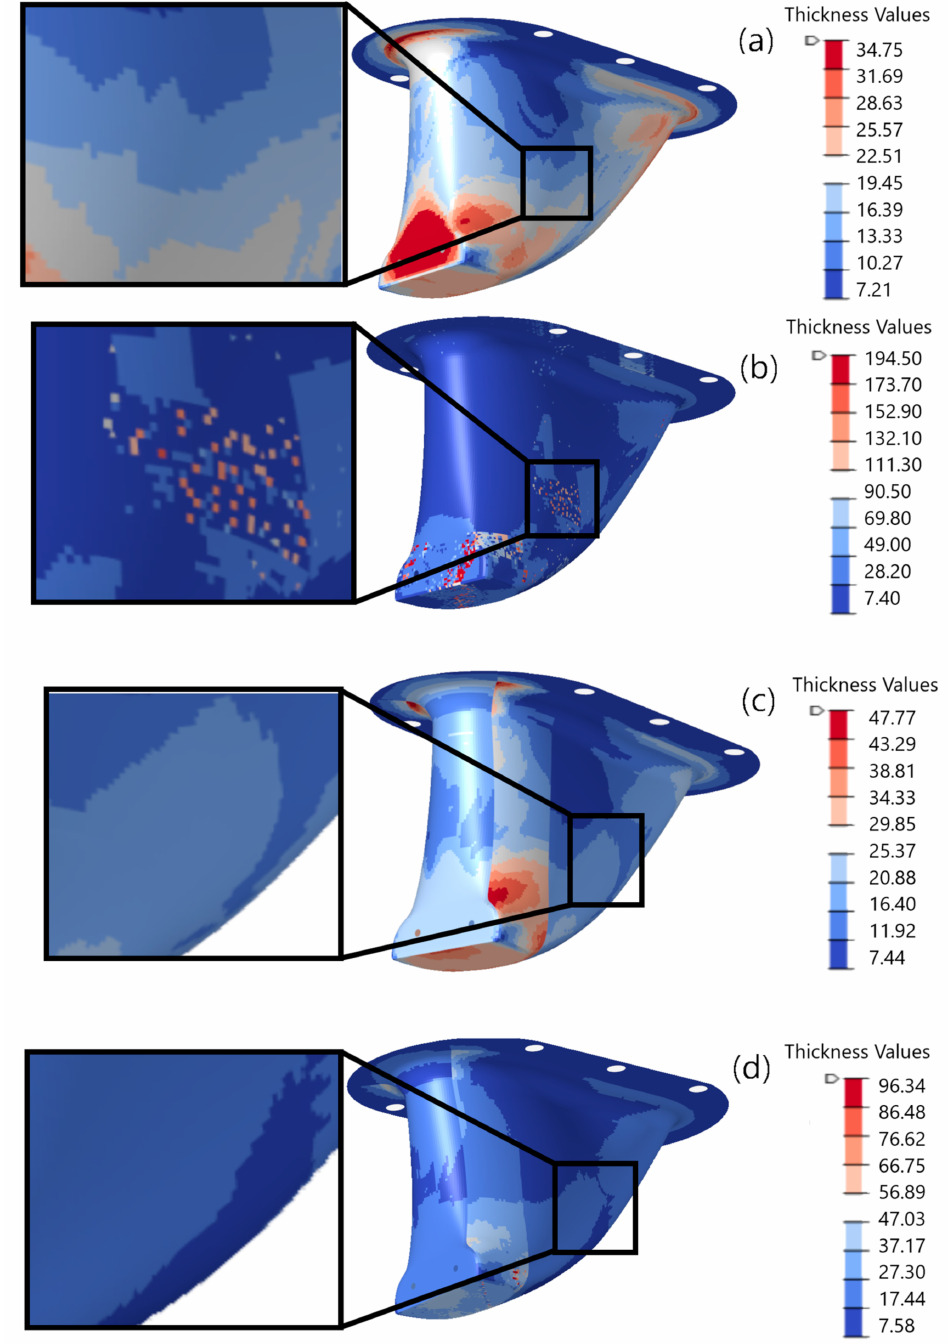
Figure 10. Laminate thickness contour plots for optimized models ( a ) integral without draping; ( b ) integral with draping; ( c ) partitioned without draping; ( d ) partitioned with